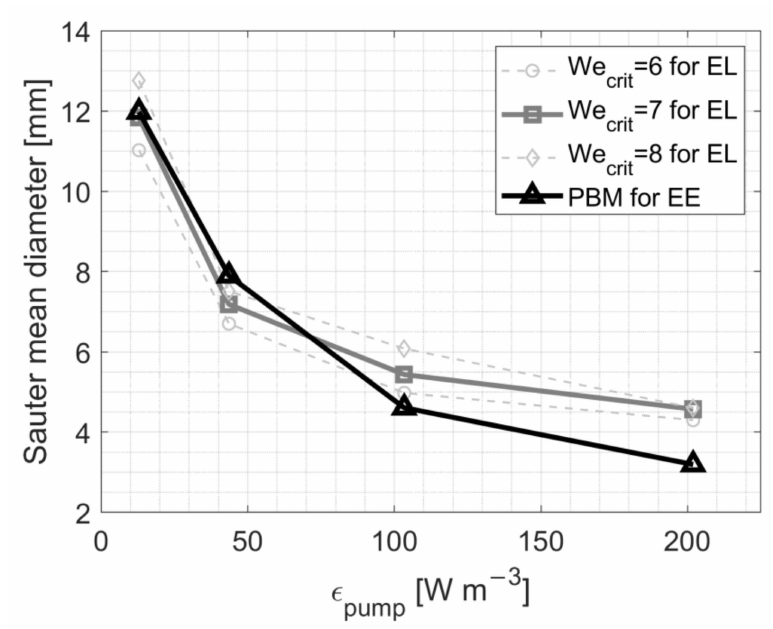
Figure A1. Sauter diameter of the bubble breakage model of Luo et al. obtained for 4 different energy input rates. The solution from the EE approach and the fitted solution with 3 different critical We numbers are shown.